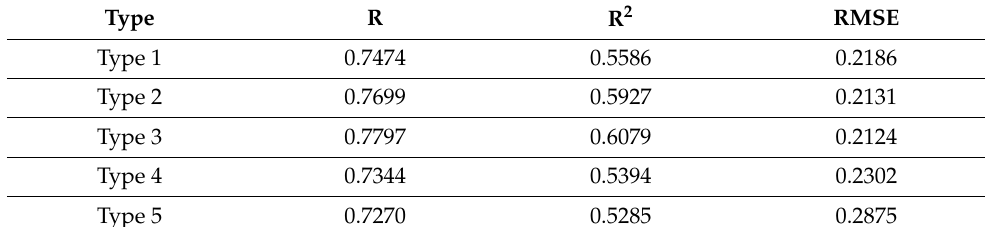
Table 9. Regression analysis results of two-dimensional equations for predicting the ultimate com- pressive strength of the SMA-confined concrete cylindrical specimens.